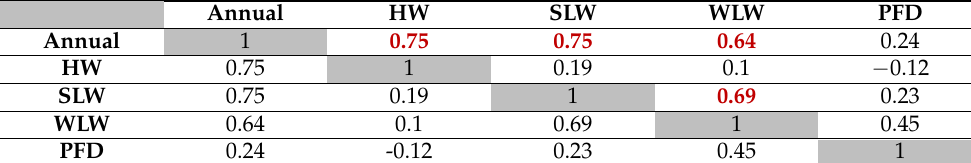
Table 6. The correlation coefficients—VKC.